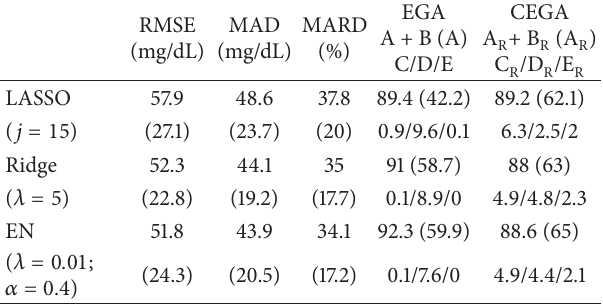
Table 1: Model test performance when “part 1” of the data set is used for model identification and “part 2” for model test. In brackets is the complexity model parameter chosen by means of cross-validation. Mean and standard deviation (in brackets) over the experimental sessions for root mean squared error (RMSE), mean absolute difference (MAD), mean absolute relative difference (MARD), error grid analysis (EGA (Clarke)) (A + B (A) C/D/E regions whose sum accounts for 100% of data points), continuous error grid analysis (CEGA) (A sum accounts for 100% of data